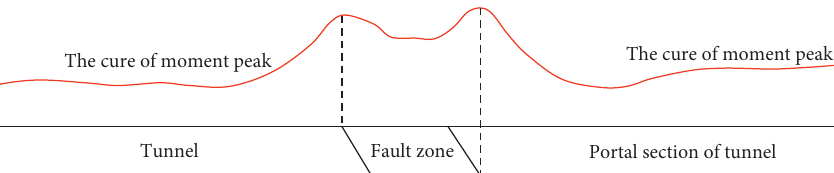
Figure 13: The peak bending moment distribution at the top left corner of the left tunnel at